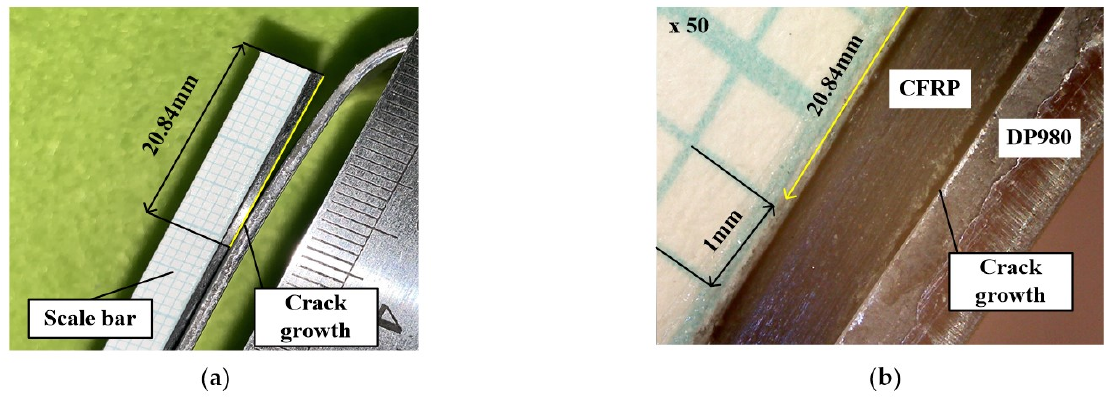
Figure 15. Microscopy images of adhesive failure in hybrid part: ( a ) delamination length; ( b ) crack-tip